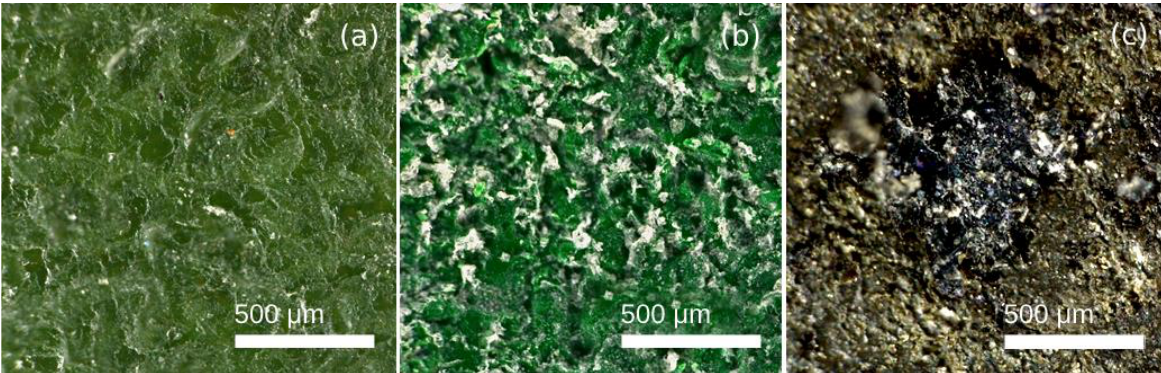
Figure 11. 2D images of the coatings after wear process of 4 s by the projection of plastic-polymer at 0.4 MPa, obtained with Leica DVM6 confocal microscope: ( a ) PFA, ( b ) FEP, and ( c ) PTFE.